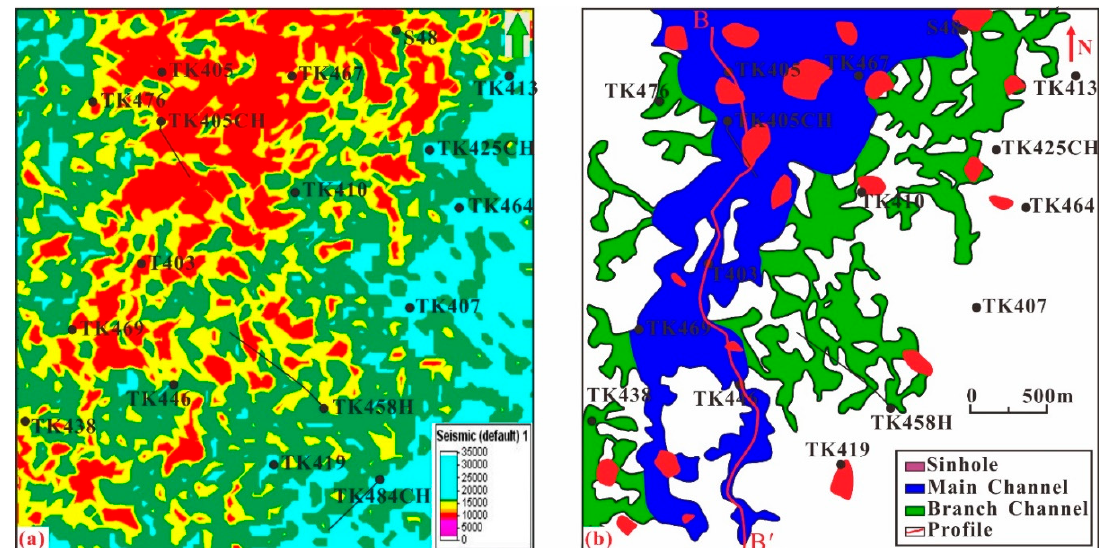
Figure 7. The interpretation results of the paleocaves in runoff zone and its geological plane. ( a ) Acoustic impedance inversion interpretation map, ( b ) corresponding geological interpretation map.